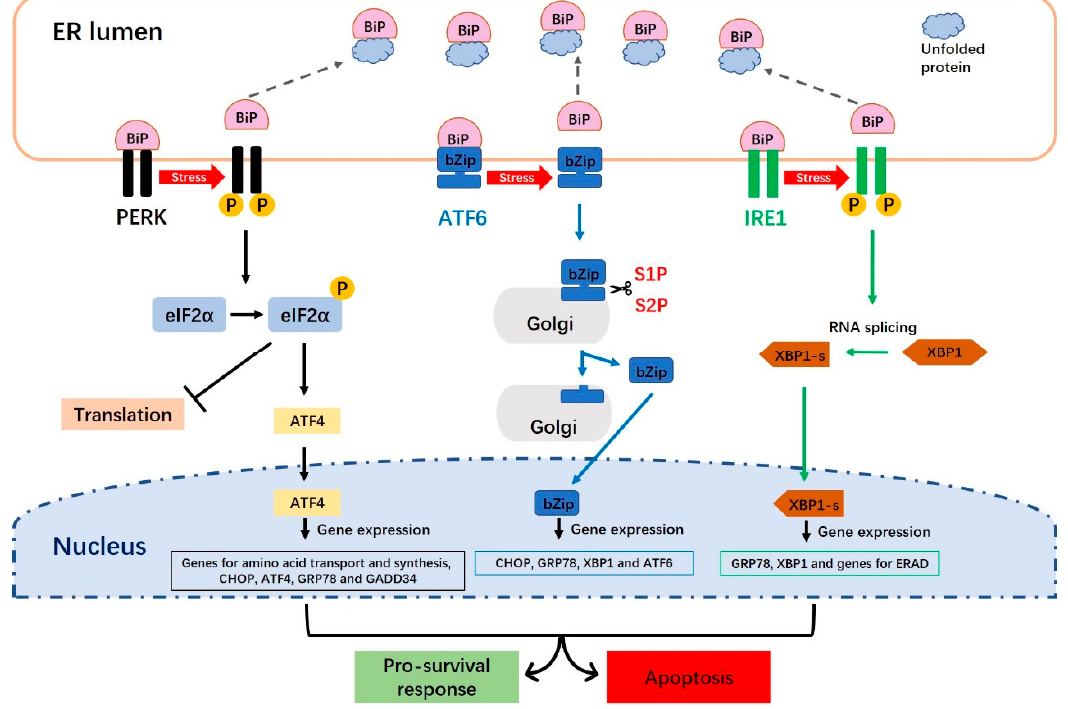
Figure 2. The unfolded protein response (UPR) signaling pathways. There are three distinct UPR signaling pathways in mammalian cells: The PERK, ATF6 and IRE1 pathways. Under normal conditions, the endoplasmic reticulum (ER) molecular chaperone, BiP, directly interacts with PERK, ATF6 and IRE1. Upon activation of the UPR, PERK undergoes dimerization and autophosphorylation, and then phosphorylates eIF-2 α to prevent the initiation of translation and block new proteins from being produced in the cytoplasm. The PERK-phosphorylated eIF2 α also activates ATF4, which translocates to the nucleus and triggers the transcription of genes required to restore ER homeostasis. When BiP is separated from ATF6, the latter factor moves to the Golgi apparatus, where it is cleaved into its active form by S1P and S2P. Cleavage of ATF6 produces a soluble basic leucine zipper (bZip) transcription factor. Active ATF6 (bZip) translocates to the nucleus and induces the transcription of ER stress-response genes via ERSE-1 and -2. The IRE1 endoribonuclease is activated through dimerization and transphosphorylation. This leads to the removal of a 26-nucleotide intron from the premature unspliced XBP1 (XBP1-u) gene form to produce the spliced XBP1 (XBP1-s) form. XBP1-s moves to the nucleus and induces UPR-responsive genes.